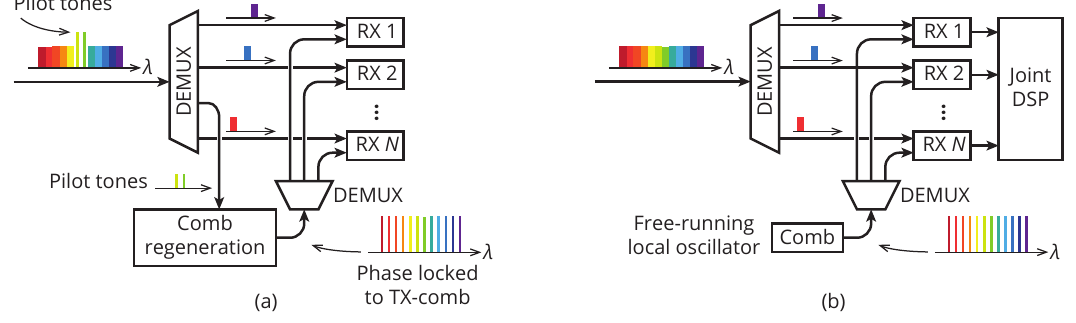
Figure 4. Schematic of two different comb-based receiver principles. ( a ) Comb regeneration based on two pilot tones. Since the local-oscillator (LO) comb is phase-locked to the transmitter comb, the receiver digital signal processing (DSP) can be simplified. ( b ) Unsynchronized local oscillator comb and joint DSP. RX: